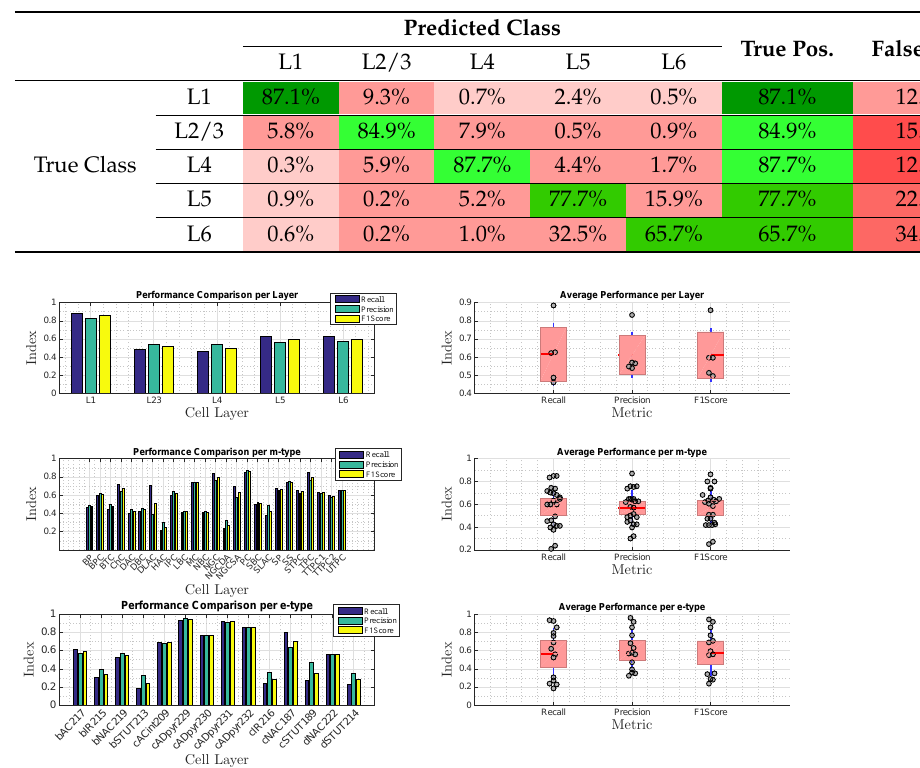
Figure 10. Results for the comparison of different types of cell layers, m-types and e-types considering recall, precision and F1 score performance. Red lines represent the mean values and the blue lines are the error